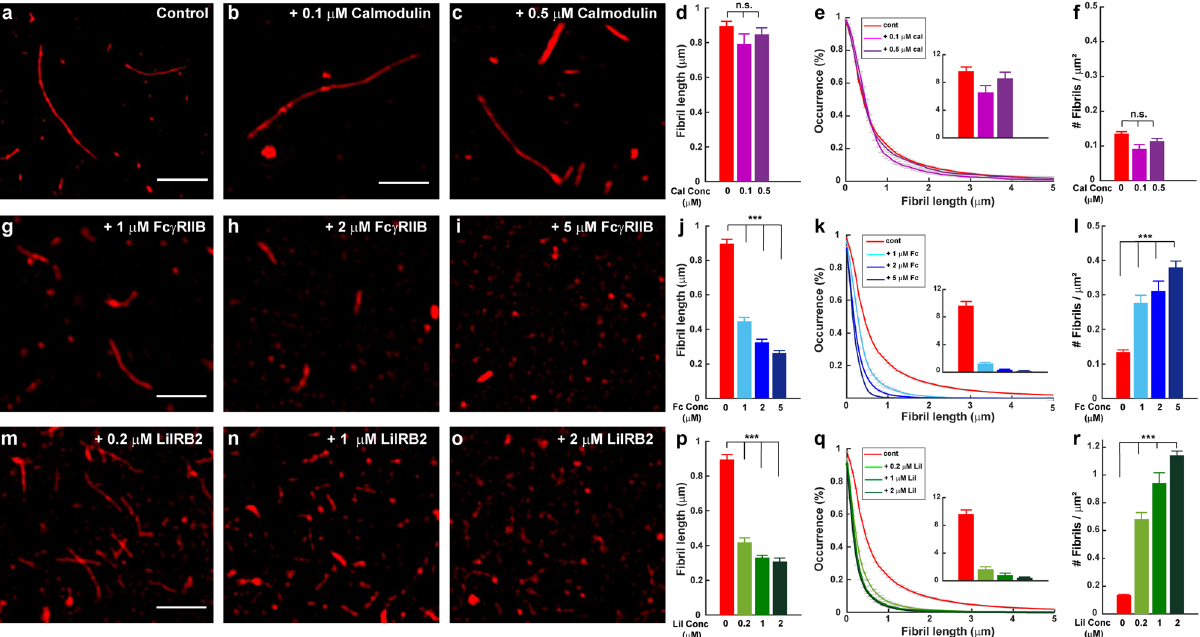
Fig. 8 Fc γ RIIb and LilrB2 promote formation of shorter, more numerous A β fi brils. A β -Cy5 monomer (20 µ M) was polymerized for 24 h under control conditions, or in the presence of calmodulin (0.1 and 0.5 µ M), Fc γ RIIb (1, 2, and 5 µ M), or LilrB2 (0.2, 1, and 2 µ M). a – c , g – i , and m – o show SIM images of the resulting fi brils. Scale bars are 2 µ m. d , j , and p show mean fi bril length under each condition. e , k , and q show cumulative distributions of fi bril length; the insets indicate the number of fi brils larger than 2 µ m. f , l , and r show the number of fi brils/ μ m 2 . Data represent mean ± S.E. and *** P < 0.001 (two-sided Student ’ s t -test). n.s., not statistically signi fi cant. Numbers of biological independent samples ( N ) and analyzed images ( X ) in each condition are: N > 3 and X > 10,